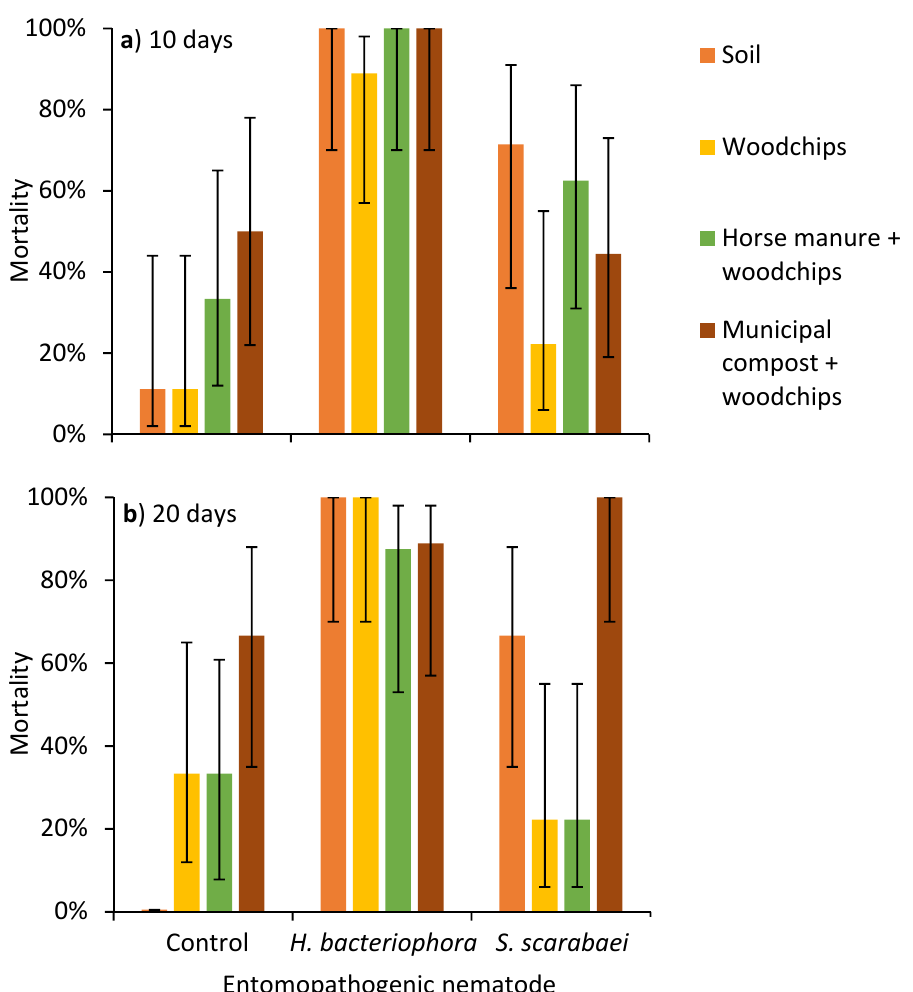
Figure 1. Mean (± 95% CI) mortality of third-instar Popillia japonica at ( a ) 10 and ( b ) 20 days at 20 °C after aqueous preparations (40 mL) of the entomopathogenic nematodes Heterorhabditis bacteriophora or Steinernema scarabaei (50 infective juveniles/cm 2 ) were added to soil, woodchips, woodchips, and horse manure or wood chips and municipal compost in plastic containers (1 L).